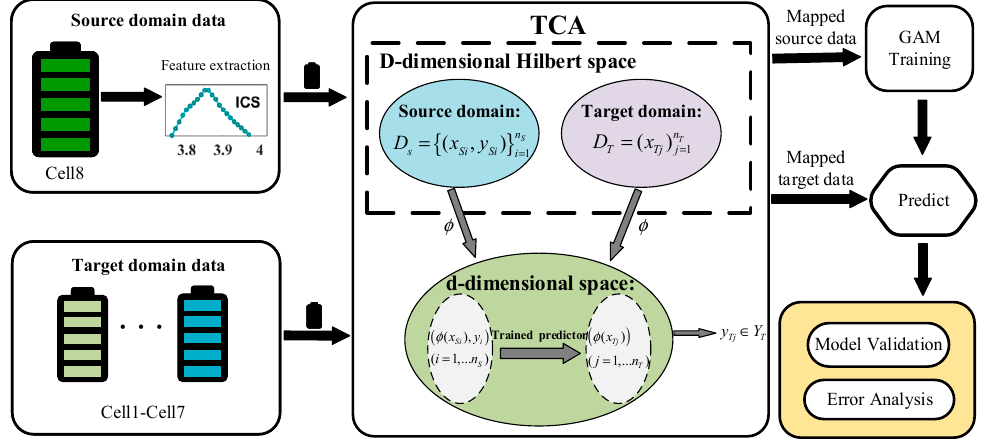
Figure 3. The flowchart of TCA-based SOH estimation algorithm.